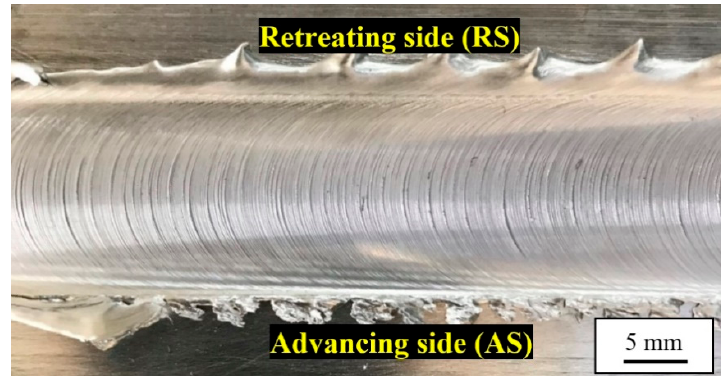
Figure 3. The weld face.